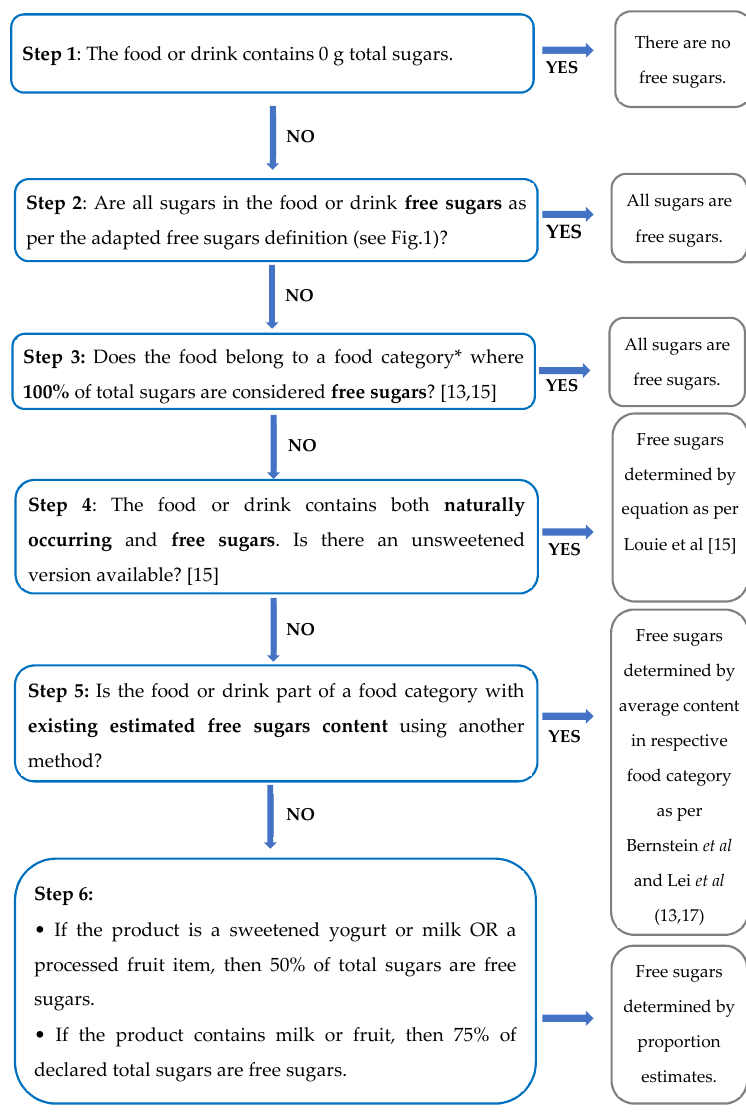
Figure 2. Flowchart Assessing Free Sugars Content in Foods without an Ingredient List.